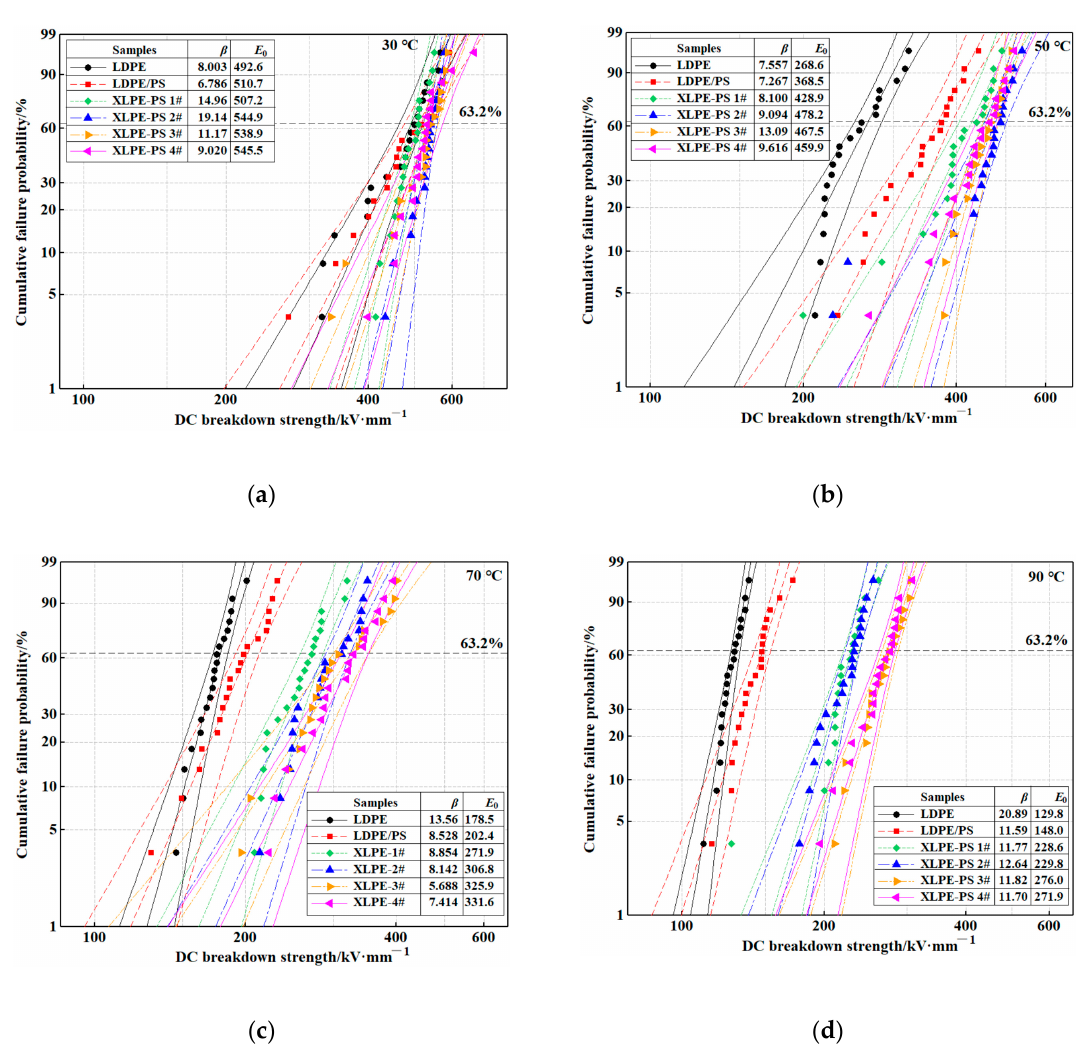
Figure 1. Weibull distribution of DC breakdown strength for samples at: ( a ) 30 °C; ( b ) 50 °C; ( c ) 70 °C; ( d ) 90 °C.